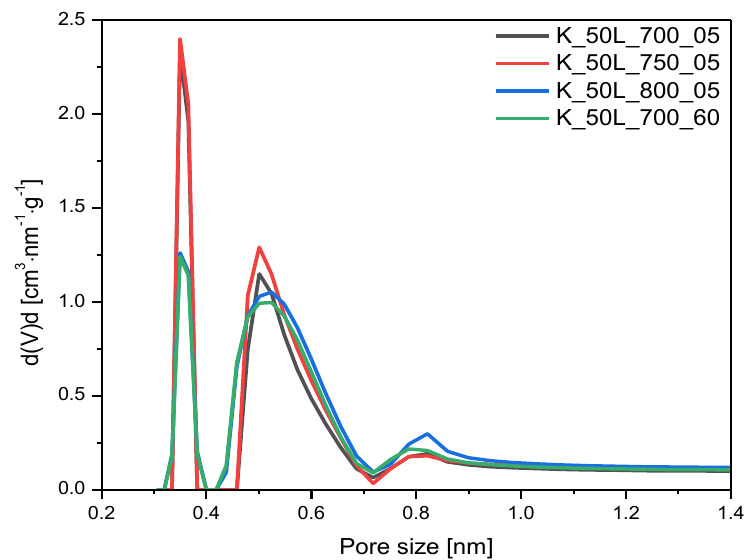
Figure 9. PSD of the samples activated at different activation temperatures and with different dwell times. The increase in KOH content added after microwave treatment from 10 wt.% to 50 wt.% and 70 wt.% resulted in an increase in ultramicropore volume from 0.12 cm 3 /g to 0.26 cm 3 /g and 0.32 cm 3 /g, respectively (Figure 10). Moreover, the increased contribution of pores of 0.35 nm in size can be noticed. For the sample where 50 wt.% KOH was added before microwave treatment, K_50L_700_05_BR, the contribution of pores of 0.35 nm is lower than for the sample where the same amount of KOH was added after microwave treatment, K_50L_700_05_AR. 0.2